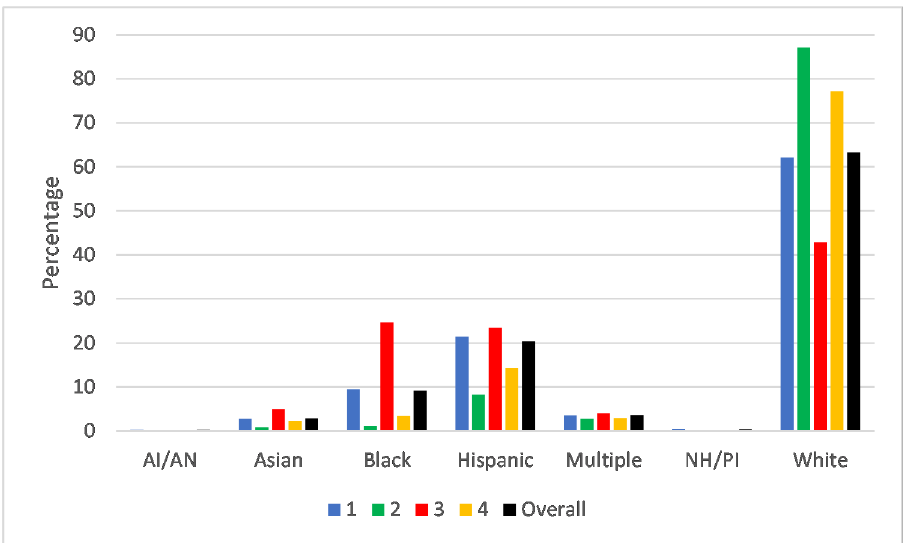
Figure 4. Percentage of individuals who fall into racial categories for overall sample of 10,000 and for each of the four clusters. AI/AN is American Indian/Alaska Native, and NH/PI is Native Hawaiian/other Pacific Islander. Same information as in Table